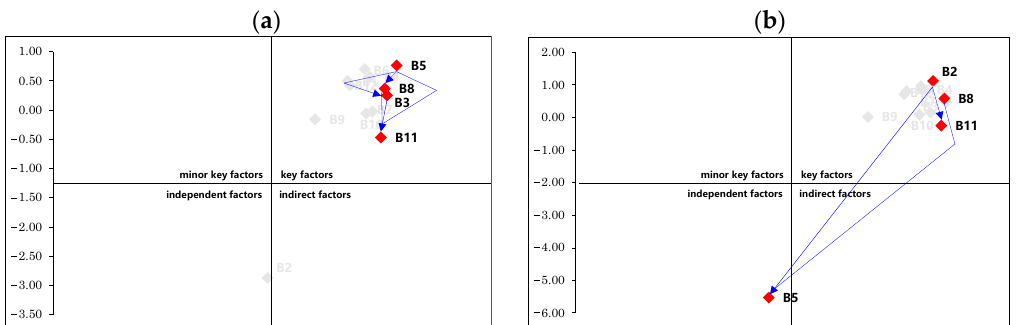
Figure 5. Prominence-relation maps for scenario ( a ) and scenario ( b ).